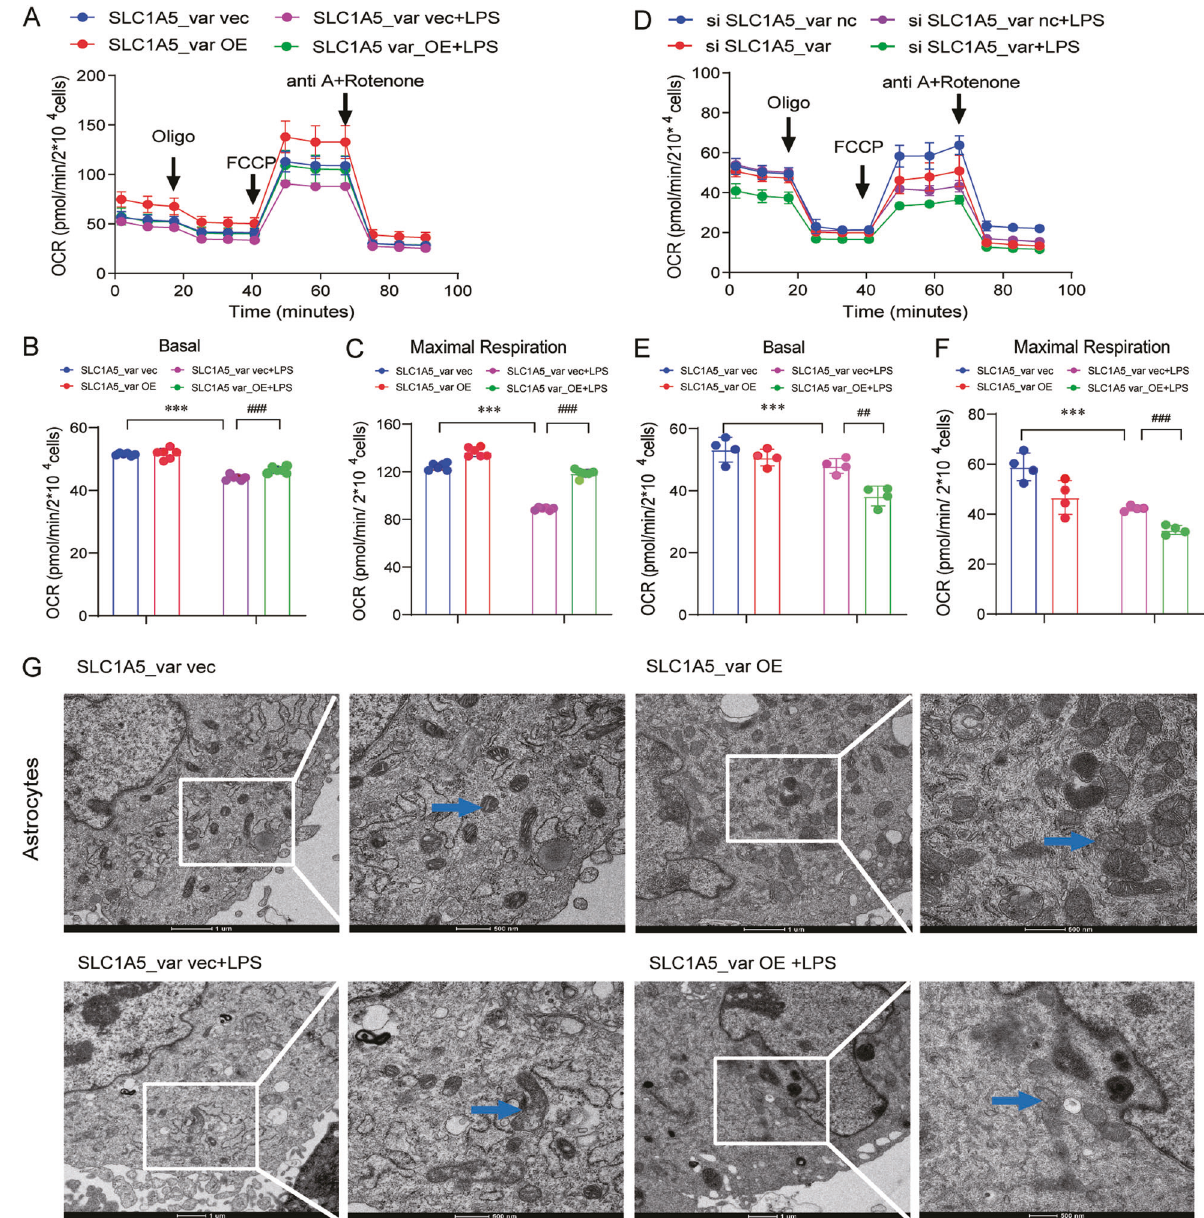
Fig. 2 SLC1A5_var ameliorates LPS-induced dysfunction of mitochondrial in astrocytes. Astrocytes were transfected with SLC1A5_var for 48 h and stimulated with LPS (100 ng/ml) for 6 h. Effect of SLC1A5_var overexpression ( A ) ( n = 6 from 6 mice/group) or knockdown ( D ) ( n = 4 from 4 mice/group) on the oxygen consumption rate in astrocytes stimulated with LPS. Effect of SLC1A5_var overexpression ( B ) or knockdown ( E ) on basal respiration of astrocytes. Effect of SLC1A5_var overexpression ( C ) or knockdown ( F ) on maximum respiration from oxidative phosphorylation in astrocytes. The non-mitochondrial respiration was not subtracted for the quanti fi cation. Each data point represents a separate well of the seahorse plate, and the astrocytes in each well were isolated from different mice. * P < 0.05, ** P < 0.01 and *** P < 0.001 vs control, ## P < 0.01 and ### P < 0.001 vs LPS group, two-way ANOVA followed by Tukey ’ s post hoc test. G The morphology of mitochondria is observed in transmission electron microscopic (TEM). Blue arrows: mitochondria. Scale bar, 1 μ m (left), 500 nm (Enlarged